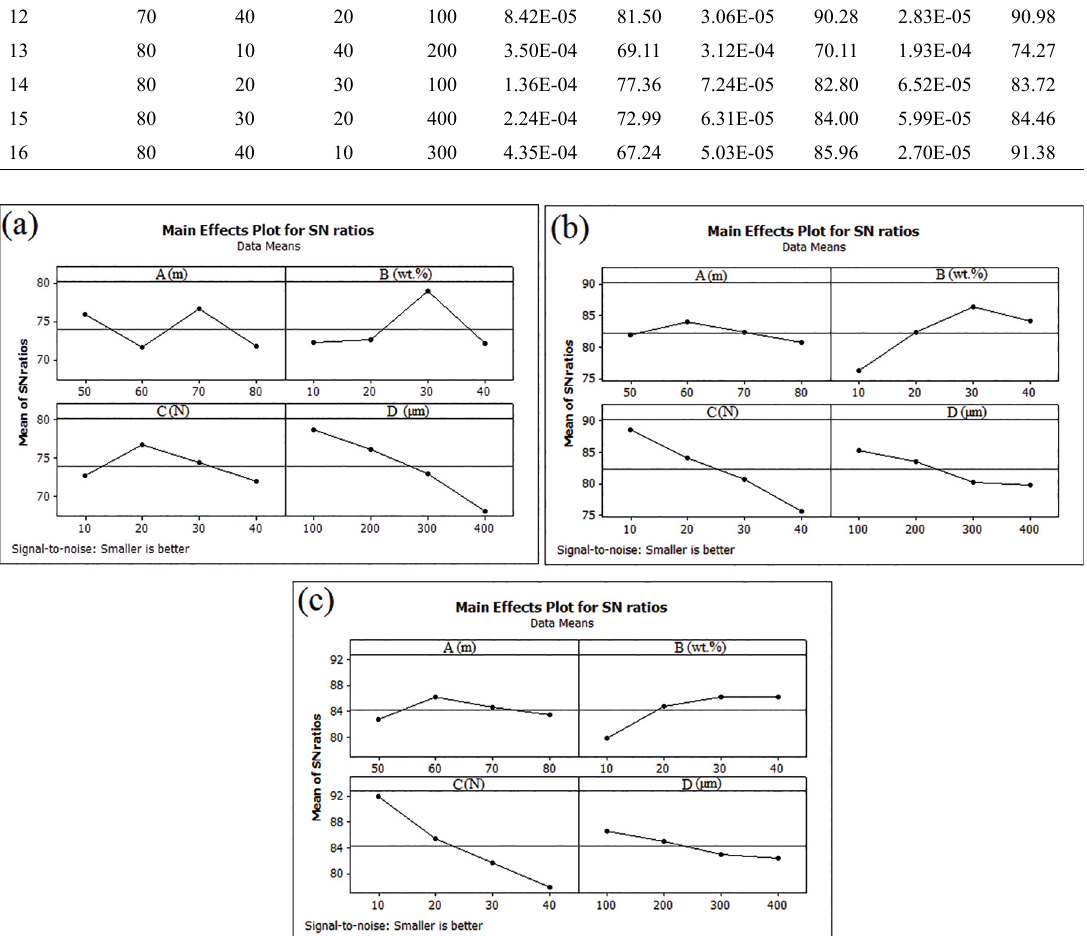
Figure 2. Effect of control factors on specific wear rate for (a) Untreated (b) Alkali treated (c) Benzoyl chloride treated jute fiber-epoxy composites.